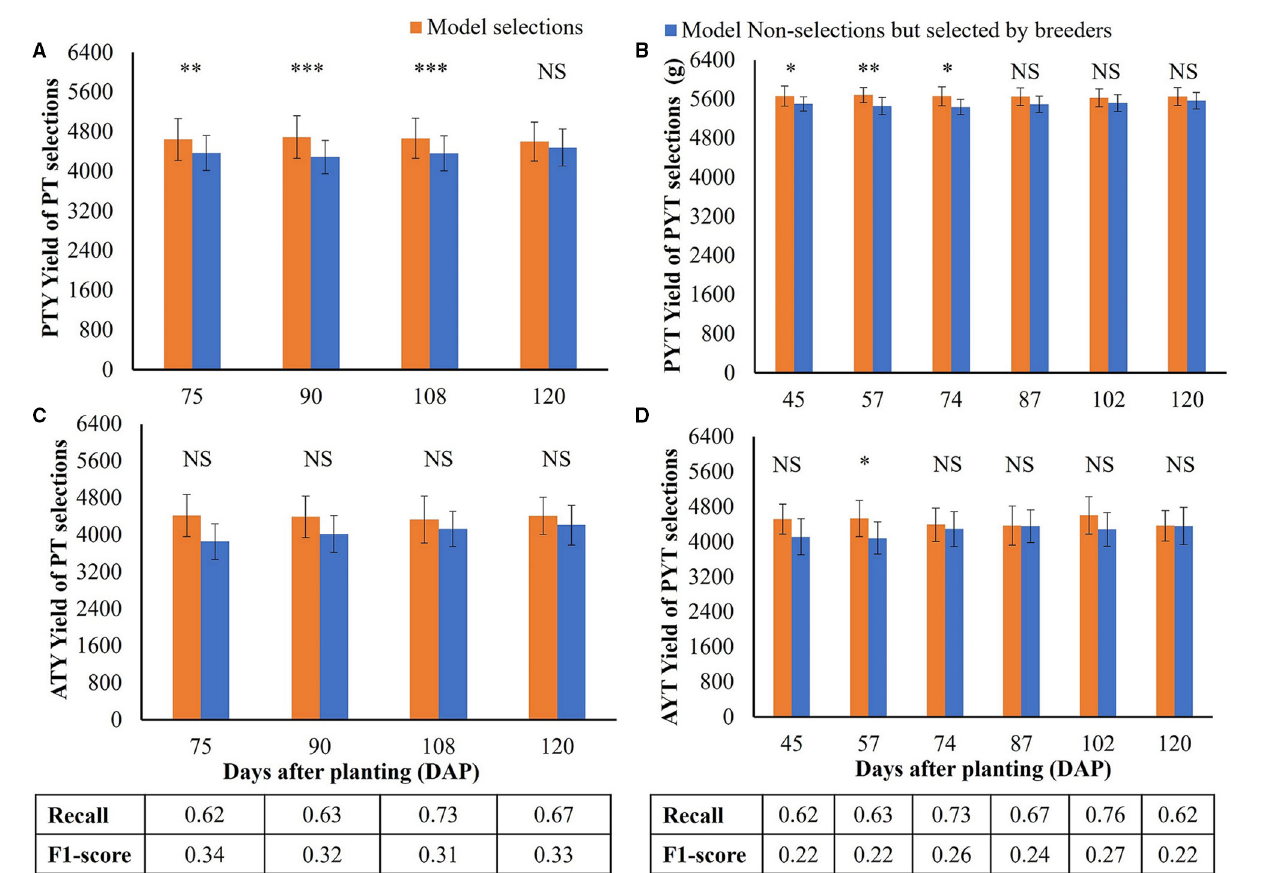
FIGURE 9 | Model performance on selecting superior soybean breeding lines from the PT and PYT. (A,C) Comparison of the PYT yield means. Yield unit: kg · ha − 1 . (B,D) Comparison of the AYT yield means. (A,B) are for the PT selections, while (C,D) are for the PYT selections. Orange and blue bars represent the model selections (the TP class) and model non-selections but selected by breeders (the FN class), respectively. Error bars show the standard deviations. *, **, and *** indicate the significance levels of p = 0.05, 0.01, and 0.001 for testing the hypothesis that there is no difference in yield means between model selections and non-selections. NS represents no significance. The numbers below the bar plots are the classification recall and F1-score for the model on each